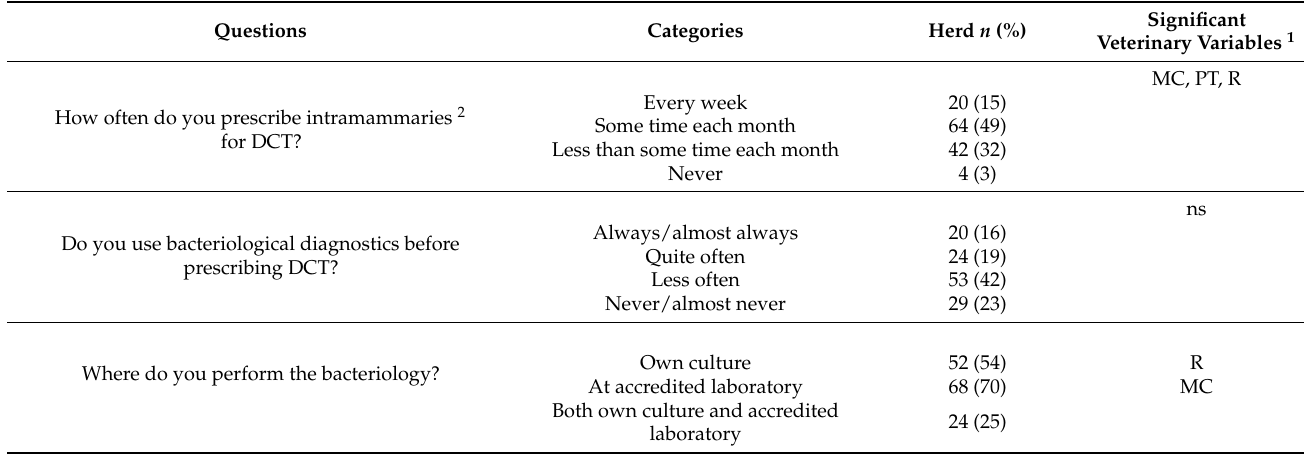
Table 4. Responses to questions about dry-cow therapy (DCT) of dairy cows with intramammaries containing antibiotics given by veterinarians ( n = 130) participating in a web-based questionnaire. The associations between veterinary variables and the answers were investigated using univariable regression models and if significant ( p ≤ 0.05) the veterinary variables are